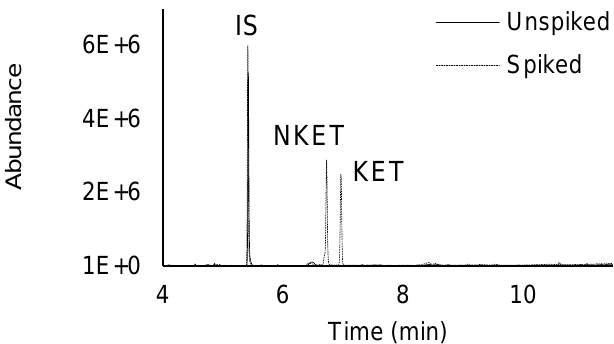
Figure 2. Total ion chromatogram of an assay from a spiked (125.0 µ g L − 1 ) and unspiked urine sample, performed by HT-BA µ E- µ LD / LVI-GC-MS(SIM), under optimized experimental conditions.